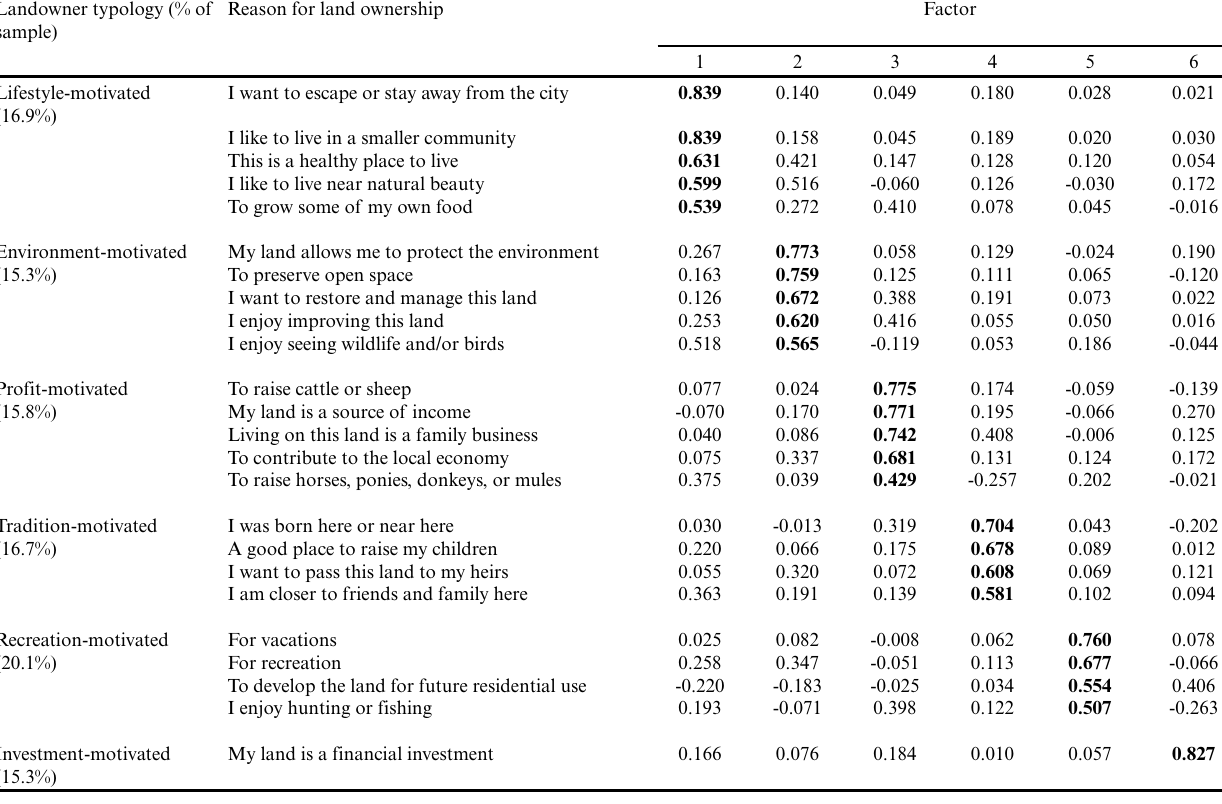
Table 1 . Landowner typologies in California’s Sierra Nevada foothills as determined via weightings in a factorial analysis from a survey question on 20 reasons for land ownership (n = 354). These six typologies accounted for 64% of the variance in reasons for land ownership. Loadings are grouped and shown in bold by their landowner